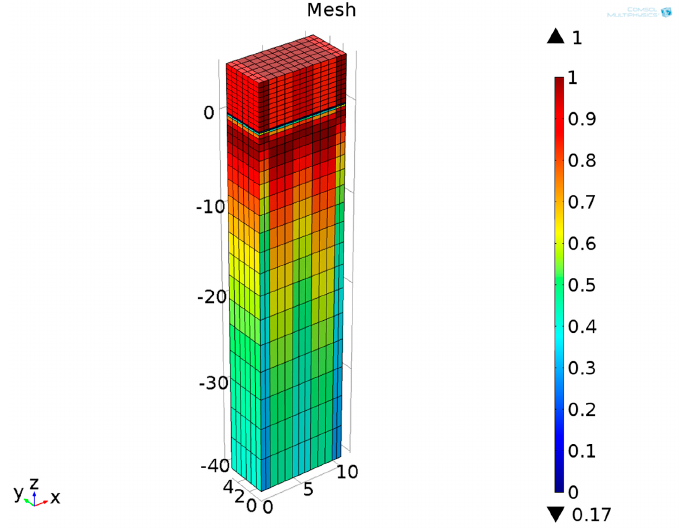
Figure 4. Meshed periodic structure in Figure 3.